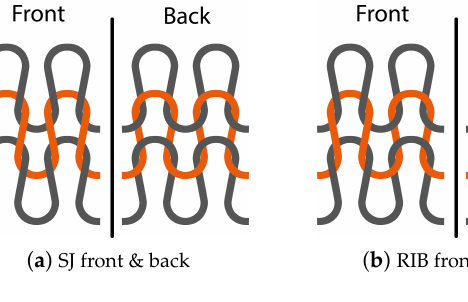
Figure 2. Overview of knit structures, own representation based on [21].